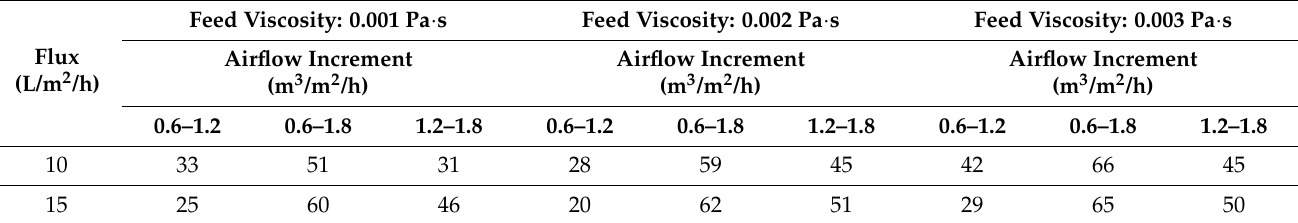
Table 1. Effect of air on cake resistance reduction (%) with varying feed viscosity.